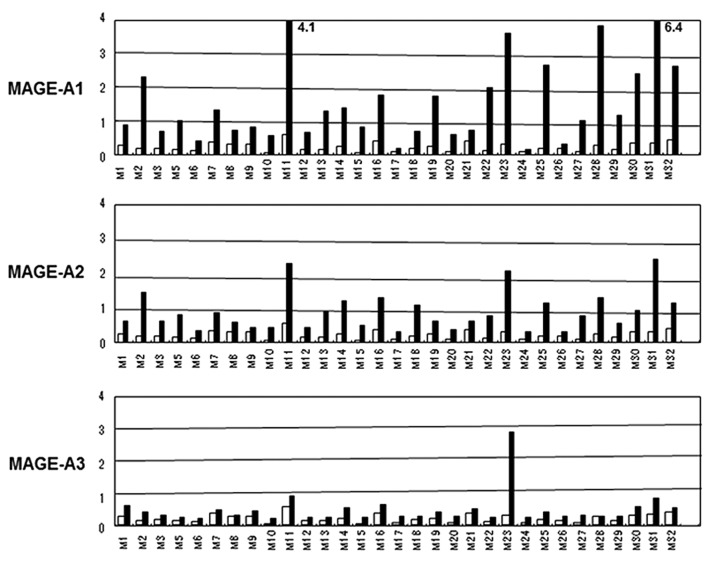
Serum autoantibody against MAGE antigens in melanoma patients before the vaccination. Sera derived from 31 evaluable cases in the phase I and II trials were analyzed. The ELISA for human antibody detection and the control reaction system were described previously. Recombinant GST-tagged MAGE proteins were used as antigens. Open column, GST alone; closed column, GST-tagged MAGE proteins for antigen.